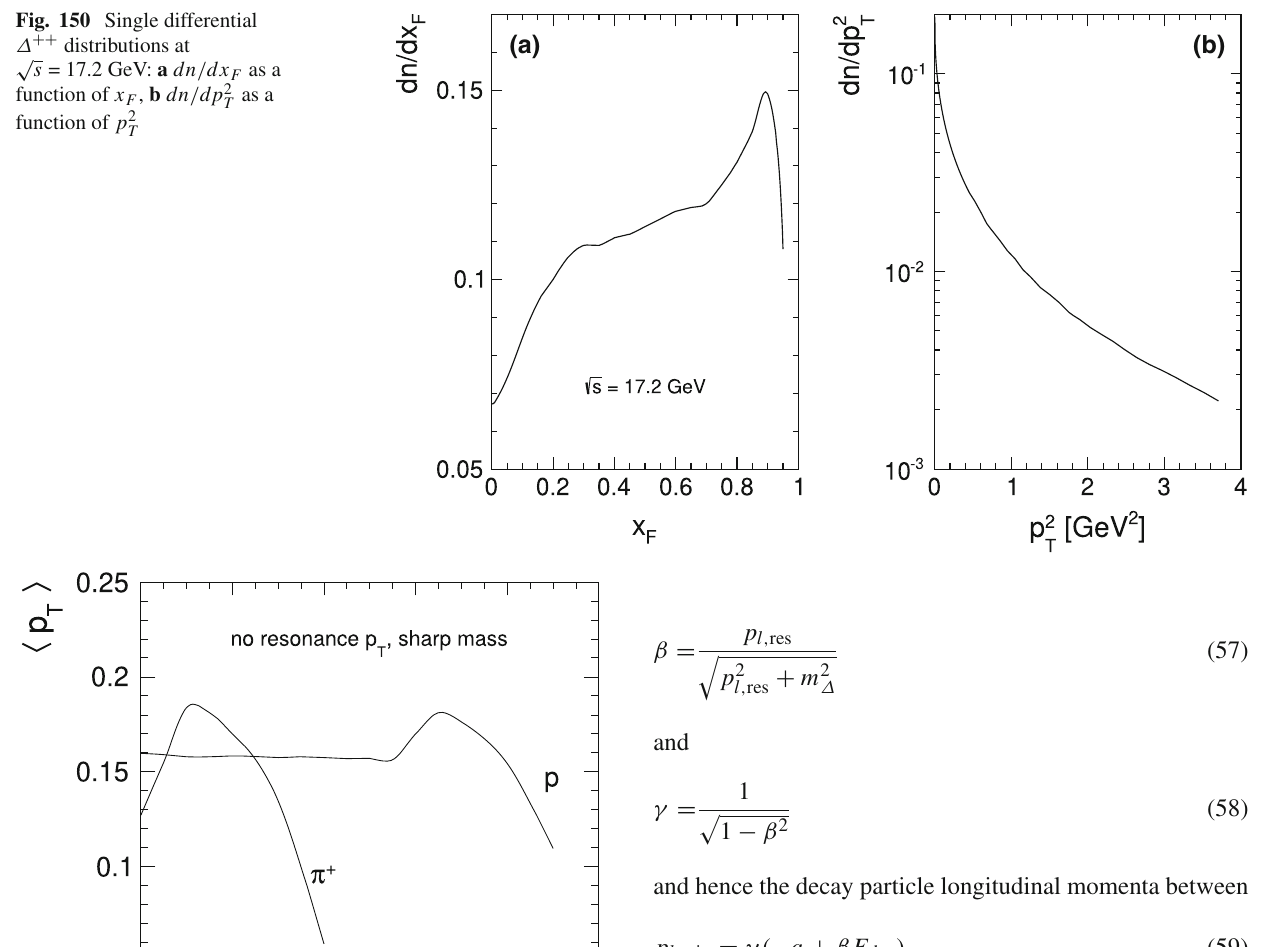
Fig. 150 Single differential Δ ++ distributions at √